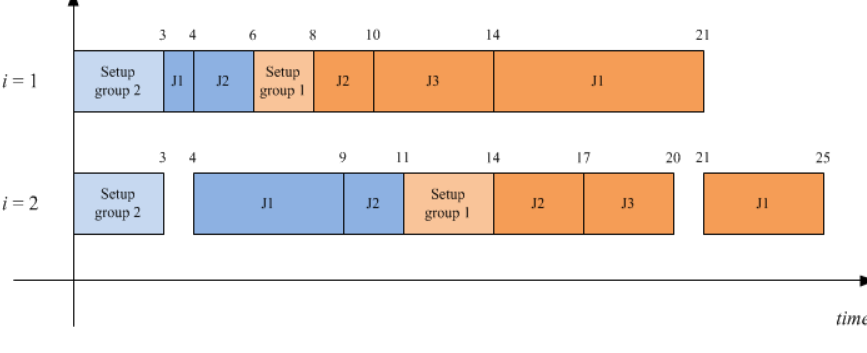
Figure 1. Gantt chart for a FSDGS example with M = 2, G = 2, n